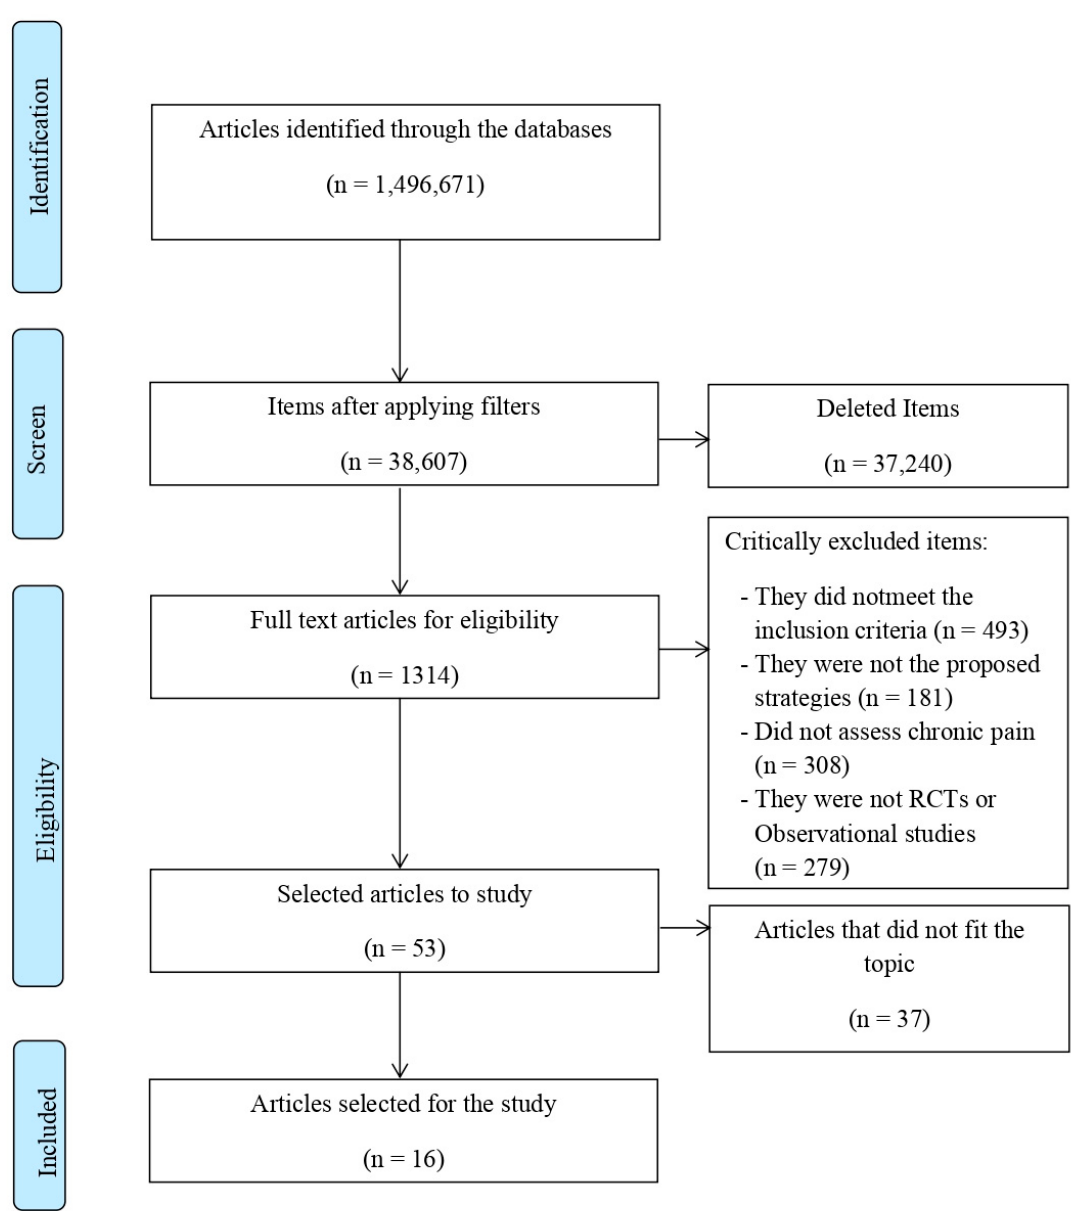
Figure 1. Flow diagram according to the PRISMA system. Study selection and exclusion process.